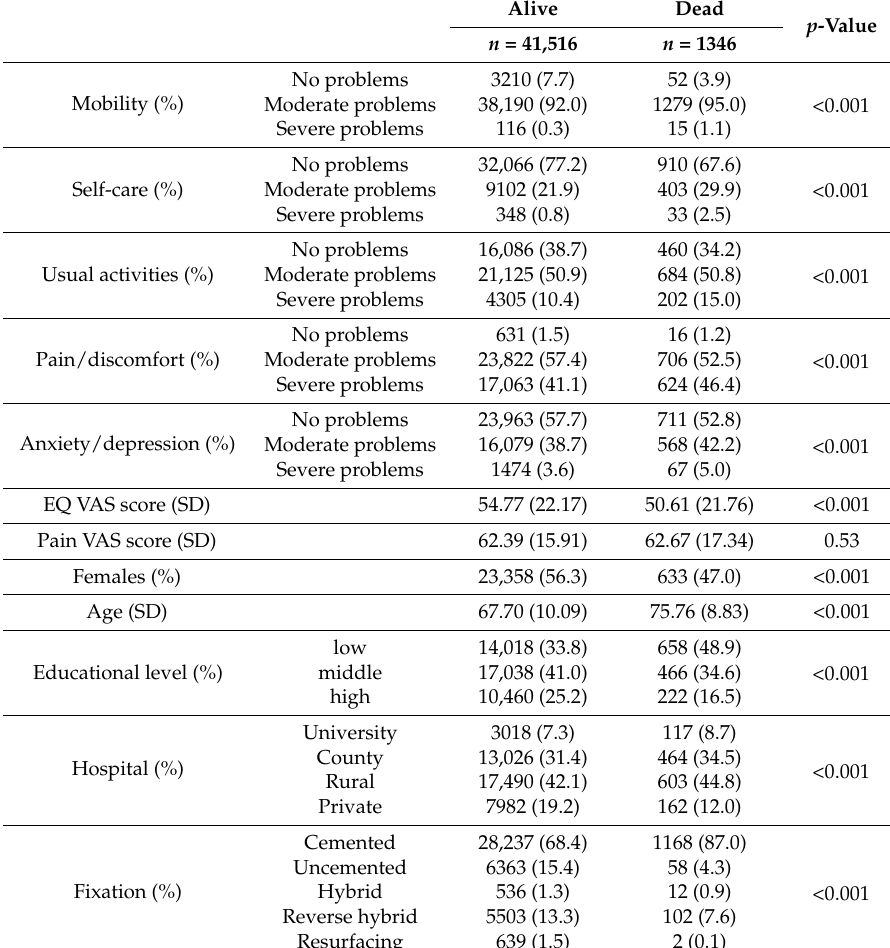
Table 1. Demographics and pre-operative, health-related quality of life of the 42,862 total hip replacement patients. The data is summarized as absolute numbers and percentages for discrete variables and means, and standard deviations (SDs) for continuous